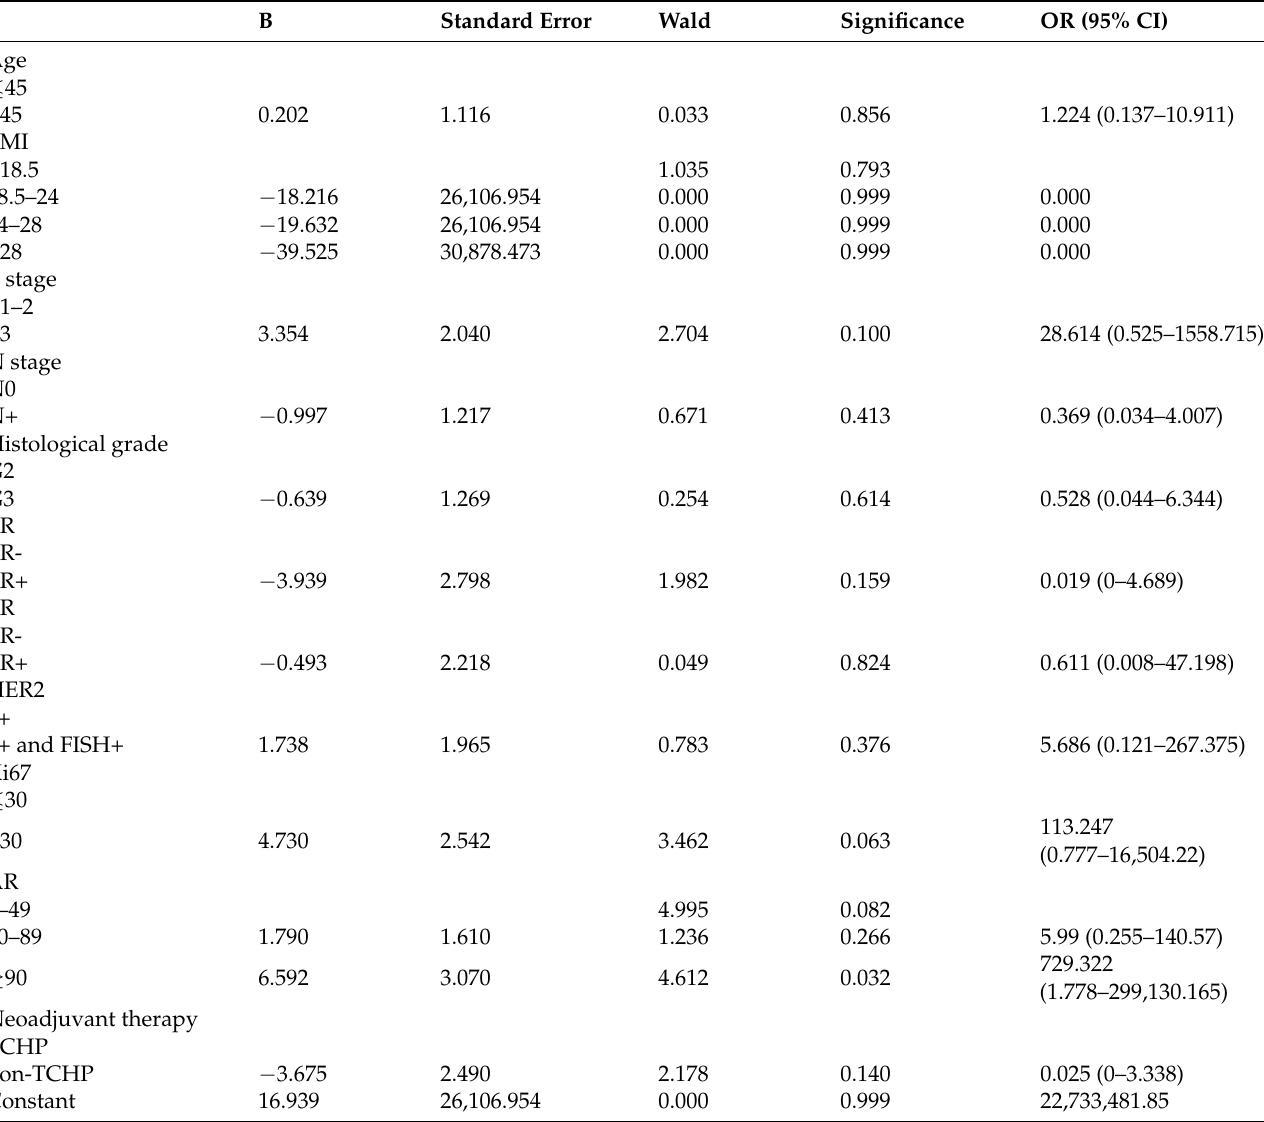
Table 2. Factors influencing neoadjuvant therapy response. BMI Body Mass Index, ER